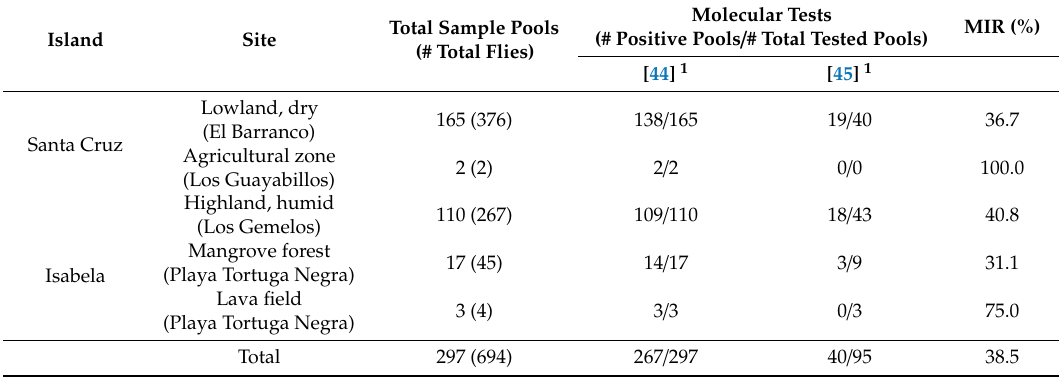
1 Indicates primer source for each